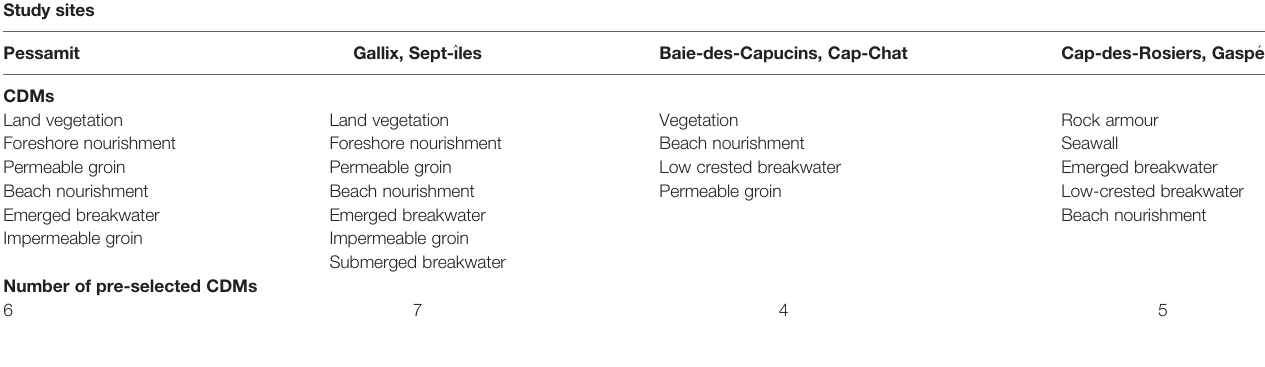
TABLE 1 | CDMs pre-selected for 3 of the study sites using Sauve ́ et al., (2022) CDMIA, and in the case of Cap-des-Rosiers, selected by a comity of experts, with the number of CDMs per